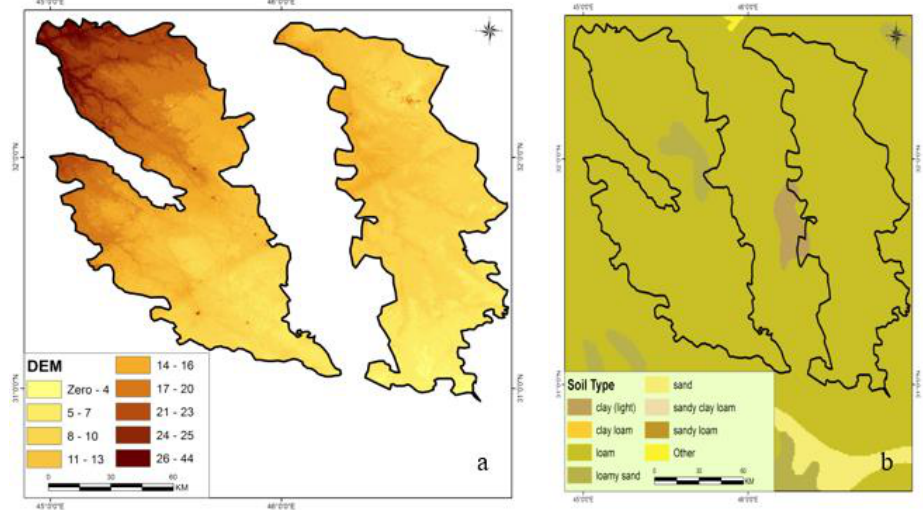
Figure 2. (DEM), SRTM 30meters, USGS ( a ) and soil map ( b ).